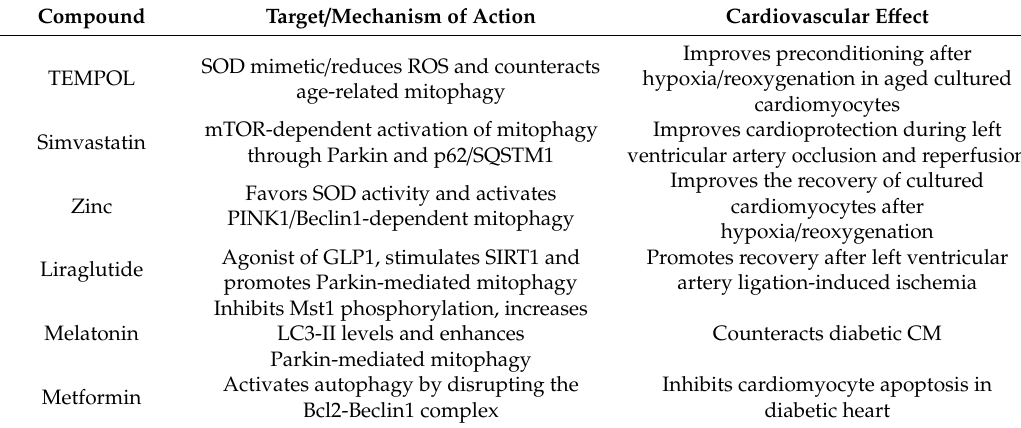
Table 2. Summary of compounds that provide significant cardioprotection via mitophagy